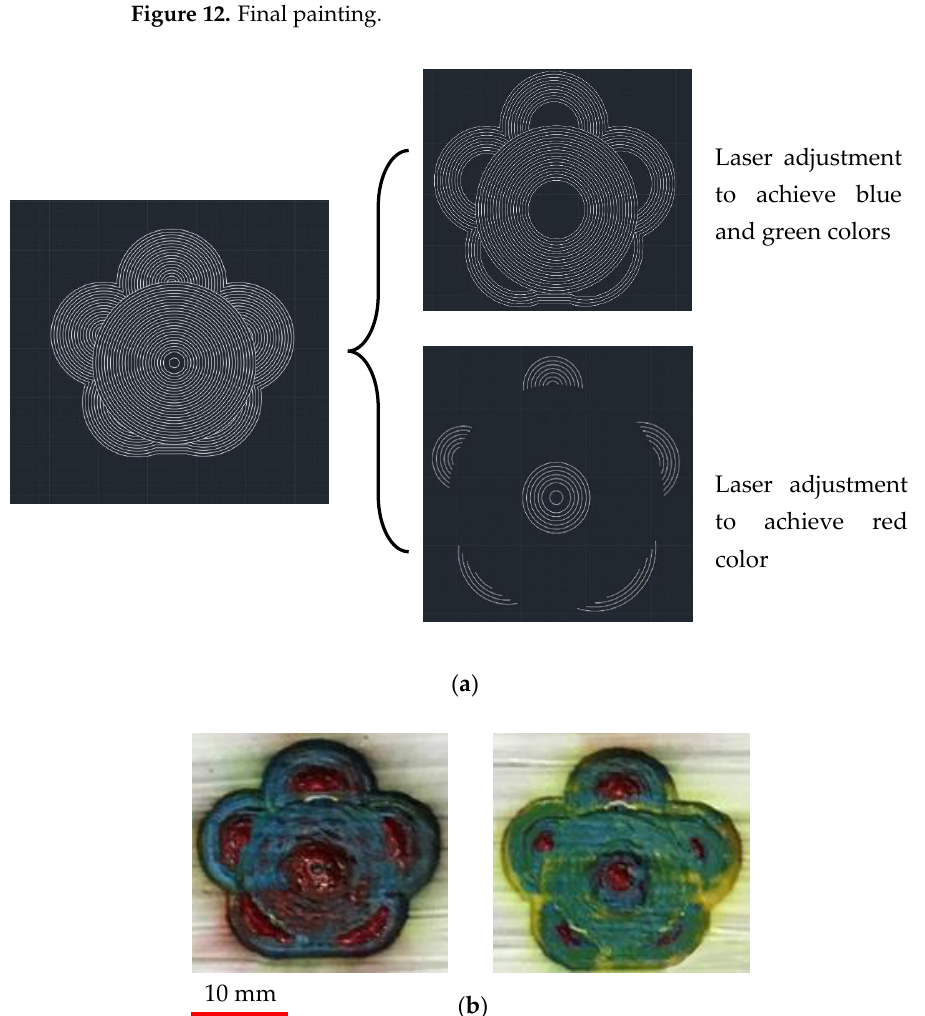
Figure 13. ( a ) Preparation of the CAD design to achieve different colors for each section of the flower. ( b ) Final result of colory flowers.